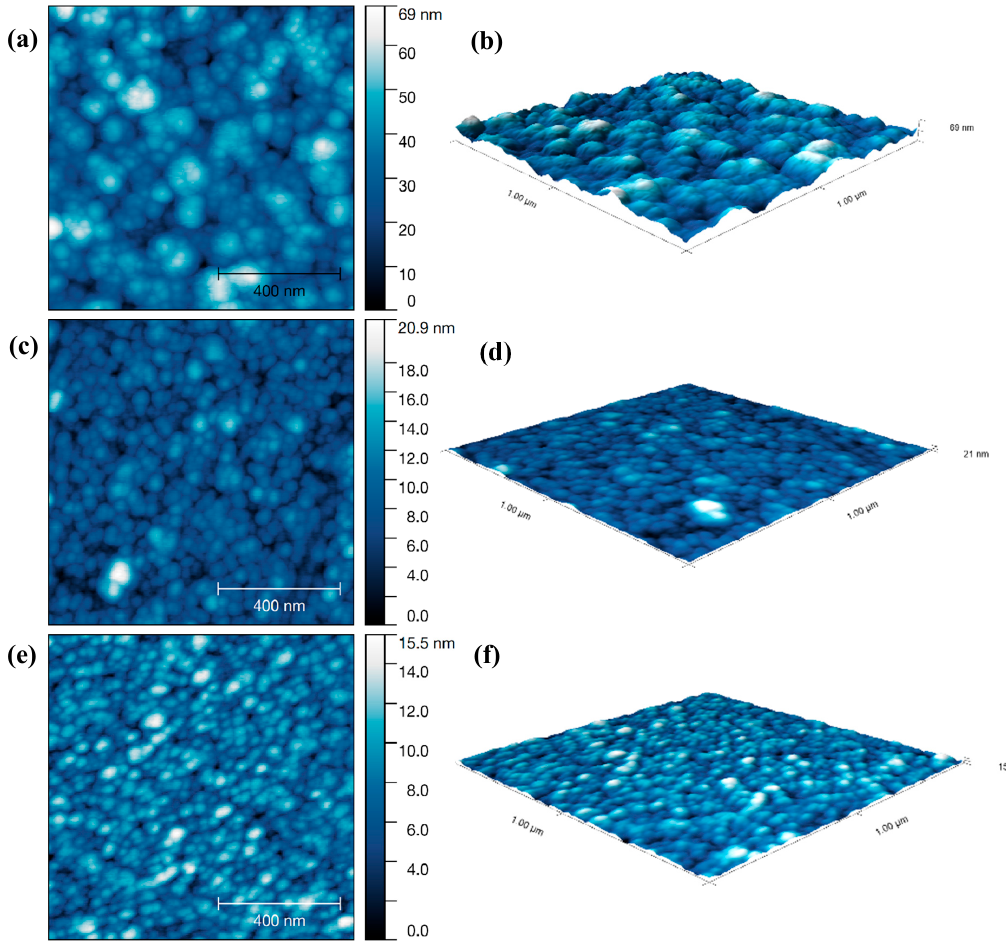
Figure 4. AFM scans and 3D images of Al 2 O 3 films deposited at 350 ◦ C via ( a , b ) continuous CVD; ( c , d ) pulsed CVD (1 min ATSB pulse) and ( e , f ) pulsed CVD (20 s ATSB pulse).